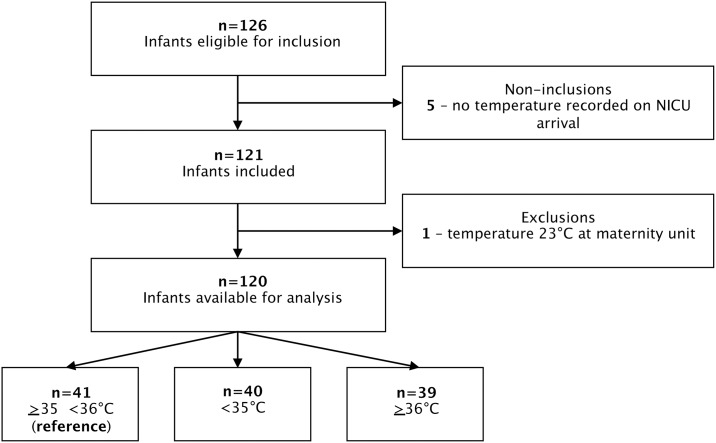
Flow chart illustrating the inclusions, exclusions and repartition of the study group.Three sub-groups with temperatures of ≥35-<36°C (n = 41, reference), <35°C (n = 40), ≥36°C (n = 39) were studied according to the temperature on arrival in Neonatal Intensive Care.